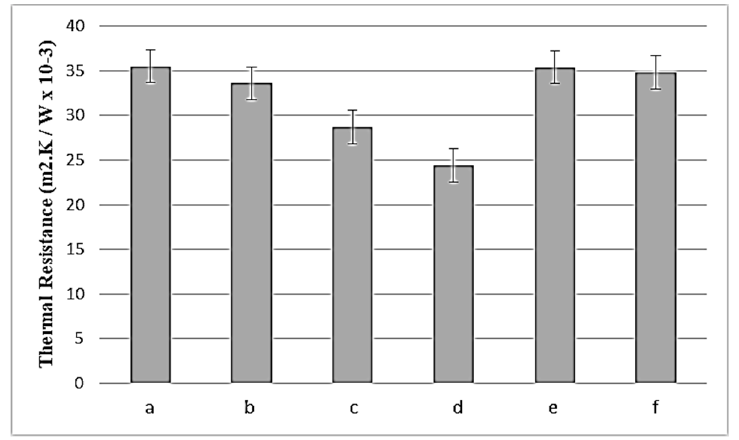
Figure 3. Thermal resistance values for each specimen versus % content in CaCl 2 based on one-way ANONA ( p < 0.01). a: untreated; b: 10 wt % CaCl 2 ; c: 25 wt % CaCl 2 ; d: 50 wt % CaCl 2 ; e: 5 washes for b samples; f: 10 washes for b samples. The data are represented as mean ± SD.